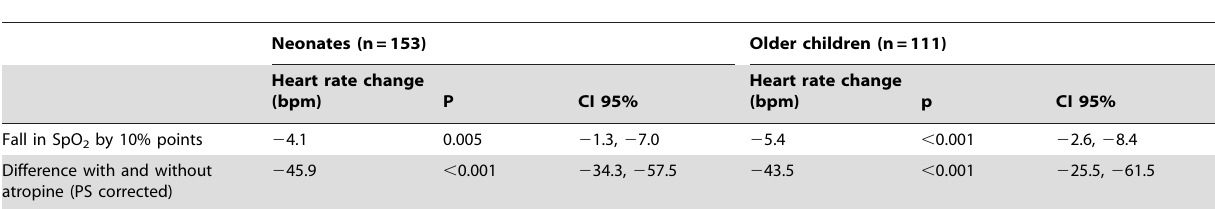
Table 4. Multivariable analysis of the change in heart rate during intubation following fall in peripheral oxygen saturation (SpO 2 ) and after the use of atropine (corrected by the propensity score [PS]). Neonates are # 28 days and older children . 28 days and less than 8